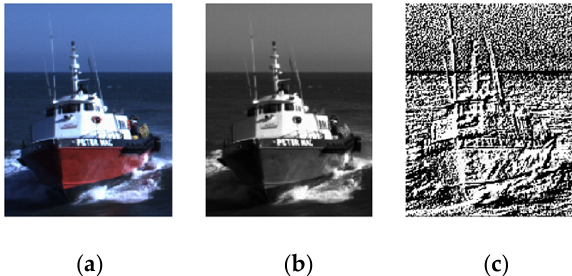
Figure 10. Illustration of the LBP feature using the VAIS dataset: ( a ) Original image; ( b ) grayscale image; and ( c ) LBP feature.